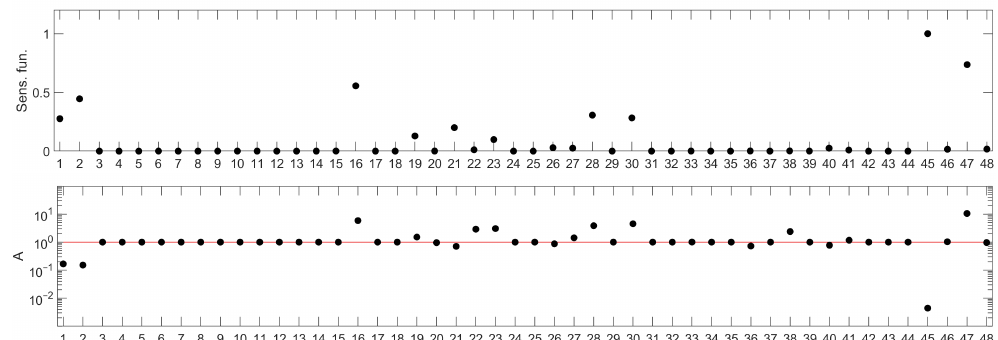
Figure 8. Parameter rankings for IFN- β -induced JAK/STAT signaling pathway model: based on sensitivity functions ( top panel ) and based on the method proposed in this paper ( bottom panel ). The horizontal ( X ) axis represents consecutive model parameters, whose names have been replaced by numbers for better readability. The parameter annotation associated with these numbers is given in Table 2. The red line in the lower panel corresponds to the A index value representing no influence of parameter changes on the model response. Points located above this line represent parameters whose change (as described in the algorithm details) amplify the model response, while those below represent the parameters whose change lead to the suppression of the model